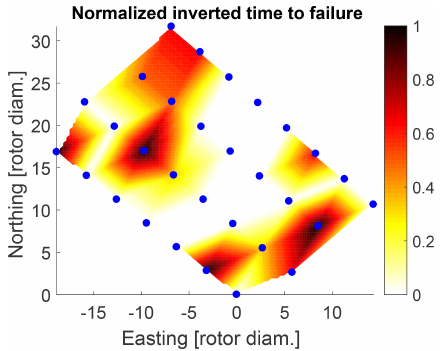
Figure 6. Observed normalized inverted time to failure within wind farm from inspection